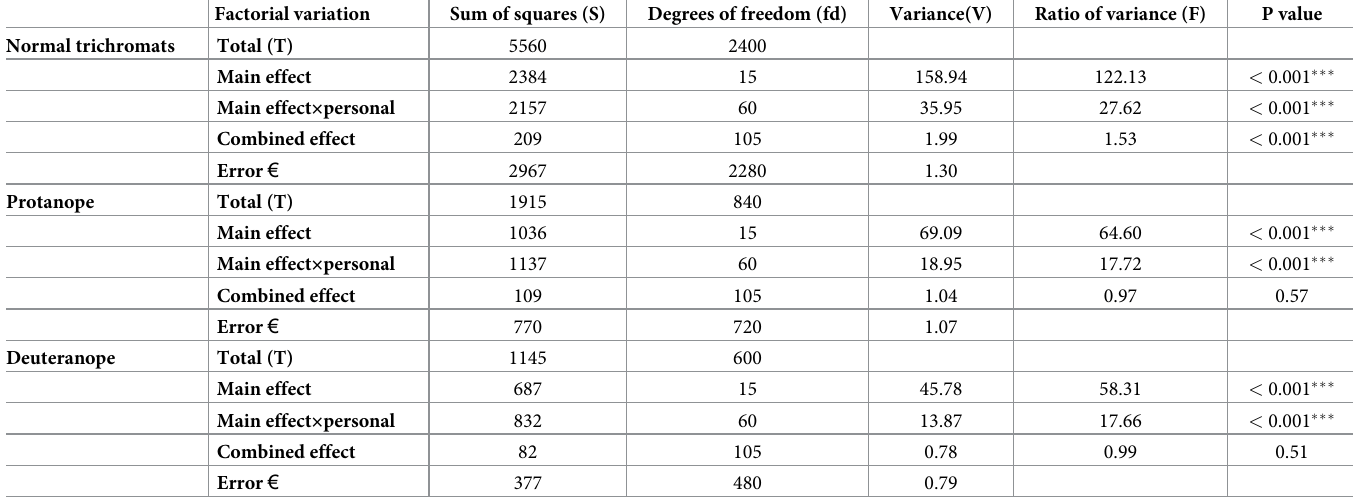
Table 2. Analysis-of-variance tables for Brightness sensitivity in the normal trichromats, protanope, and deuteranope using Scheffe´’s method. Factorial